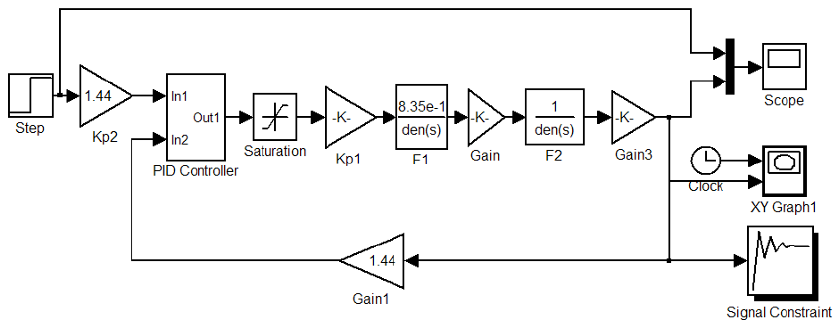
Figure 11. Module block diagram of the heading angle adjustment circuit.